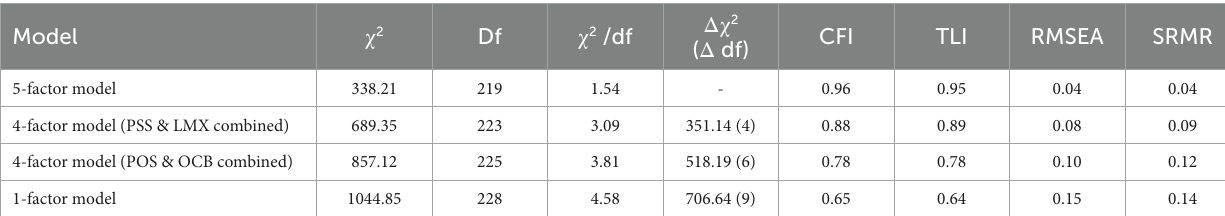
TABLE 3 CFA Results.